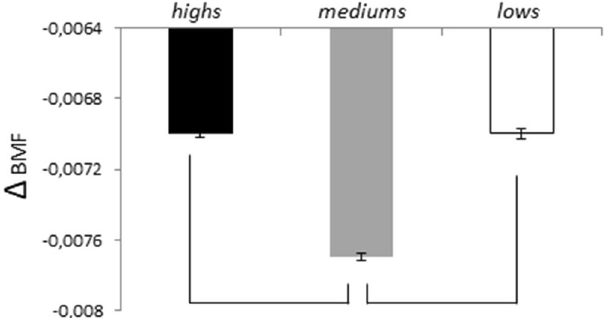
Figure 3. Changes (Δ I6-I1 ) in the pupil spectrum Band Median Frequency. BMF (Mean, SEM). Lines indicate significant differences between mediums and highs/lows.